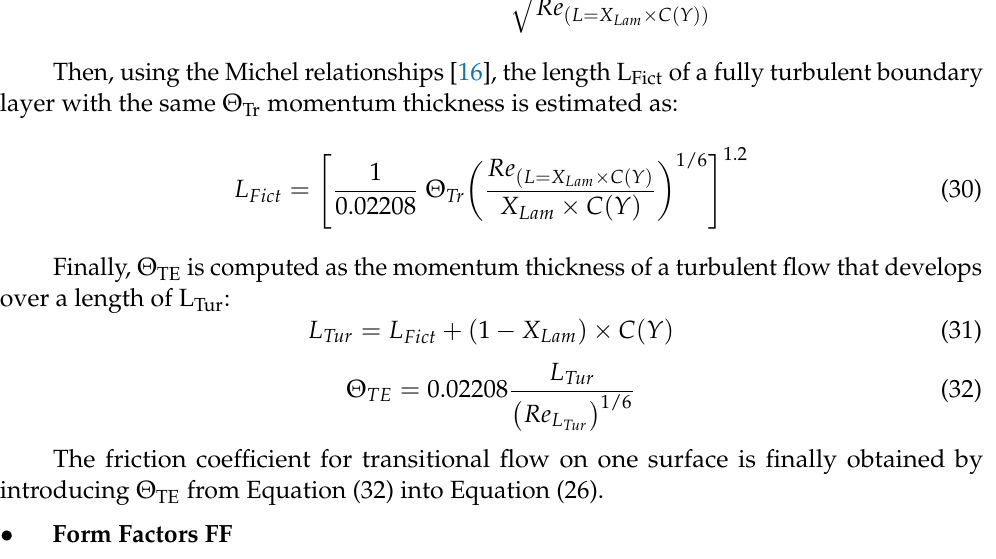
( b ) Figure 11. Simplified model used for transition location on wing surfaces. ( a ) Model for transition